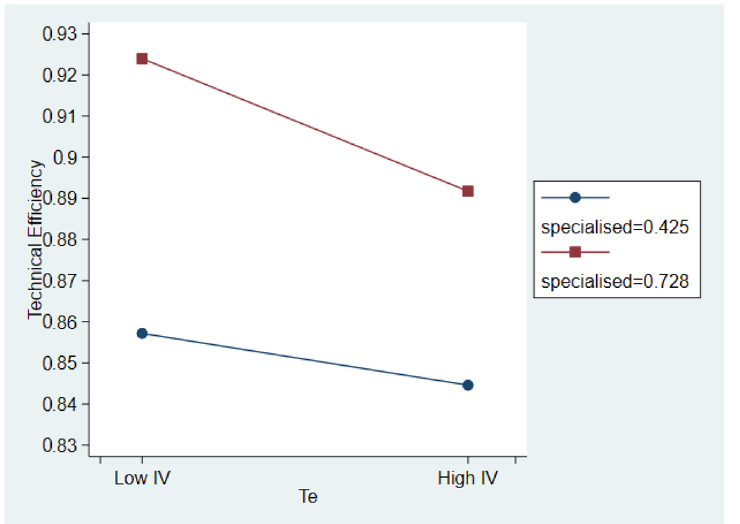
Figure 4. Moderating effect of farmers ’ cropping